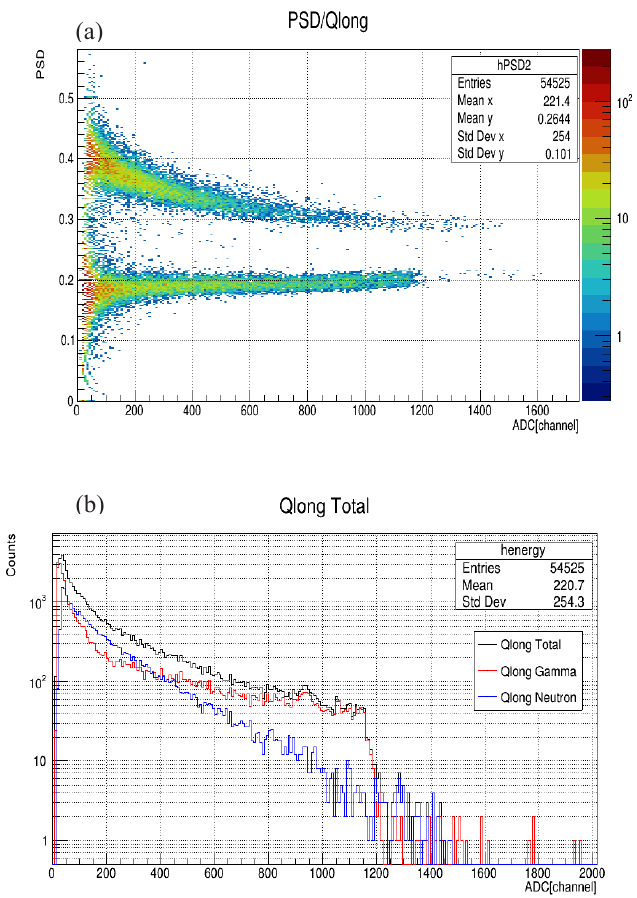
Figure 4 (a) The PSD vs. Q L of the AmBe source; (b) Light amplitude for various Q L when applying a cutoff value to the